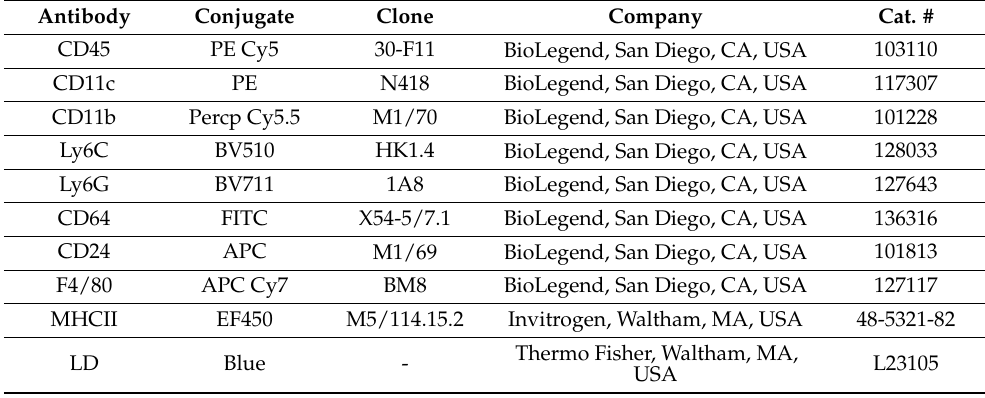
Table 2. Antibodies used for flow